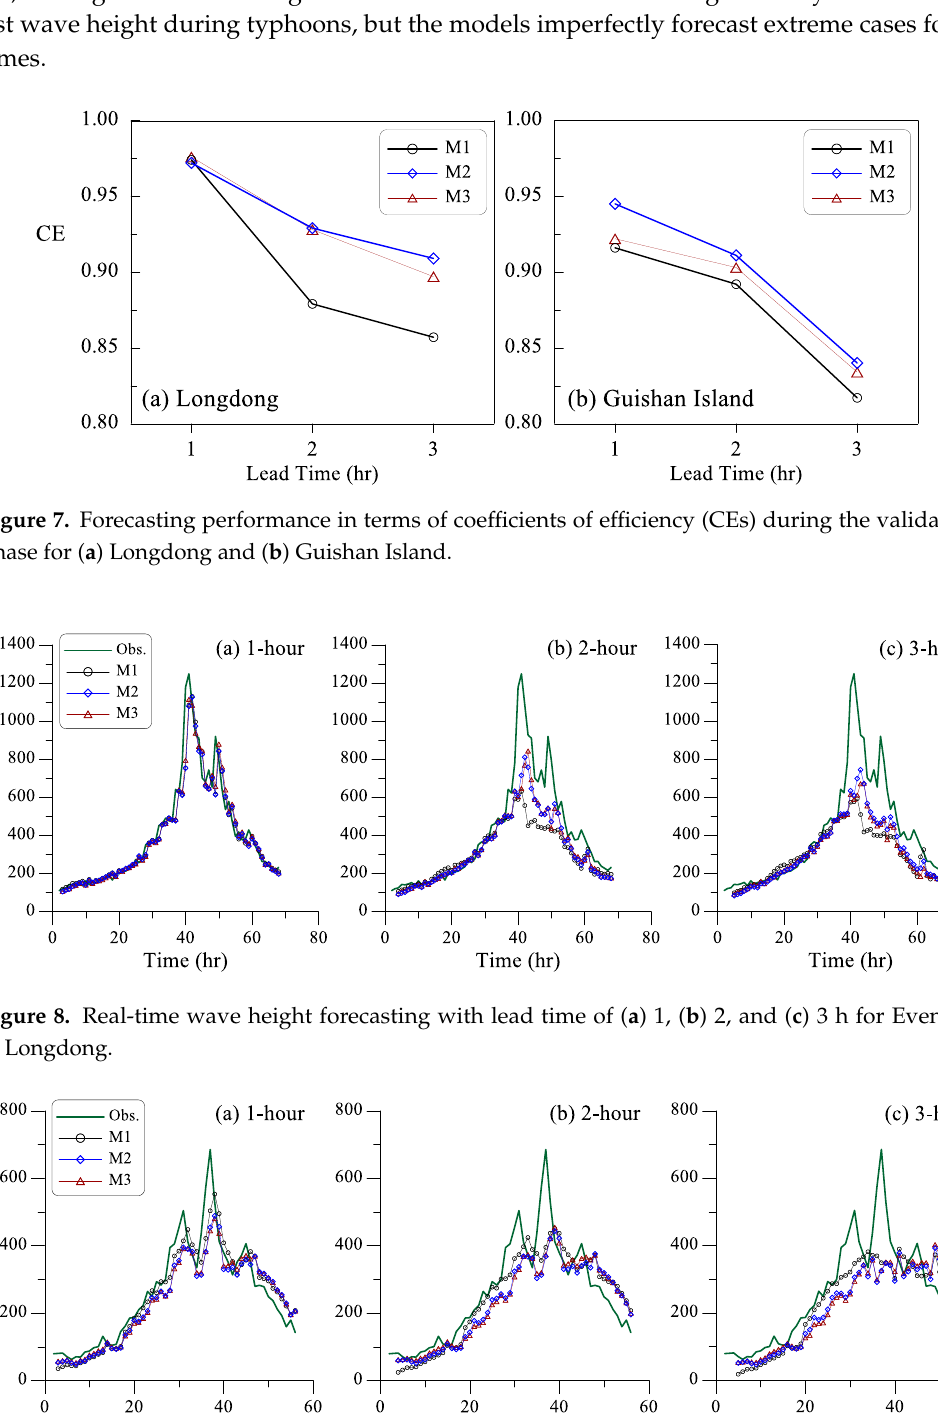
Figure 6. Forecasting performance in terms of RMSEs during the validation phase for ( a ) Longdong and ( b ) Guishan Island.